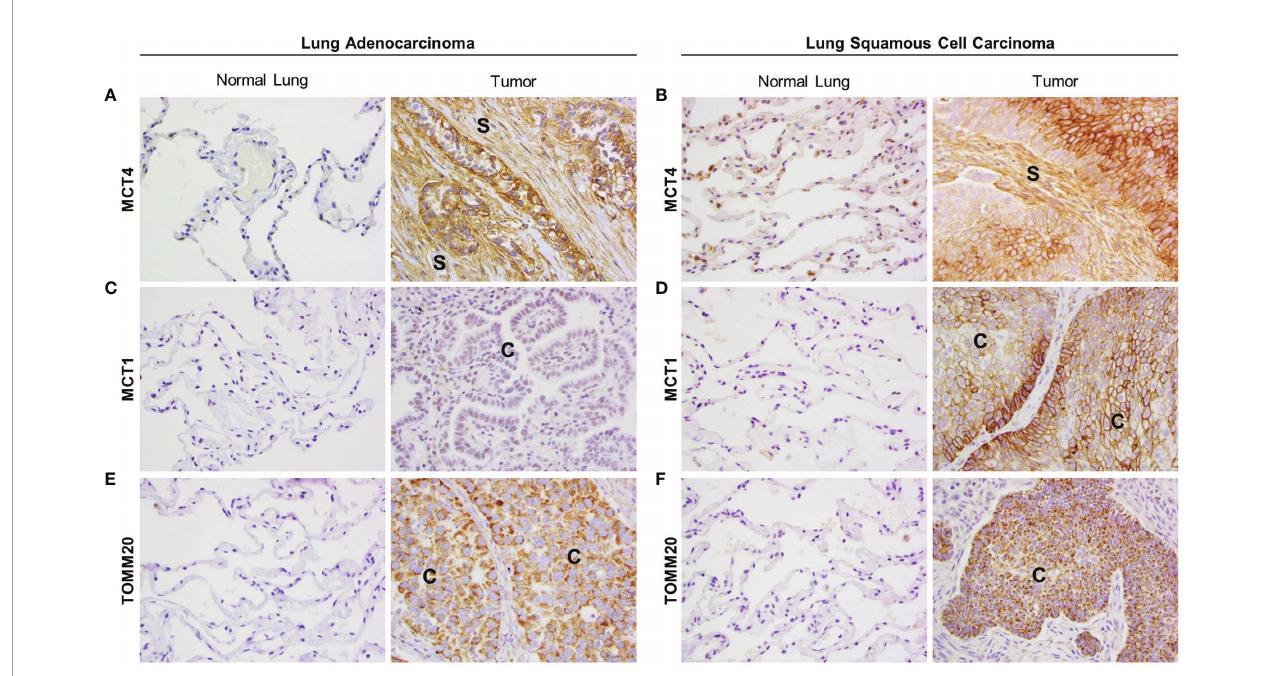
FIGURE 1 | Expression of markers of metabolic compartmentalization in non-small cell lung cancer (NSCLC). Lung adenocarcinoma (LUAD) and lung squamous cell carcinoma (LUSC) patient samples were stained for MCT4, MCT1 and TOMM20 by immunohistochemistry. For each marker, representative images were taken from tumor tissue and adjacent normal lung tissue within the same sample. (A, B) MCT4 expression in the tumor stroma of LUAD (A) and LUSC (B) and their corresponding adjacent normal lung. (C, D) MCT1 expression in carcinoma cells in LUAD (C) and LUSC (D) and their corresponding adjacent normal lung. (E, F) TOMM20 expression in carcinoma cells in LUAD (E) and LUSC (F) and their corresponding adjacent normal lung. Images were taken at 20X. (S, stroma; C, carcinoma